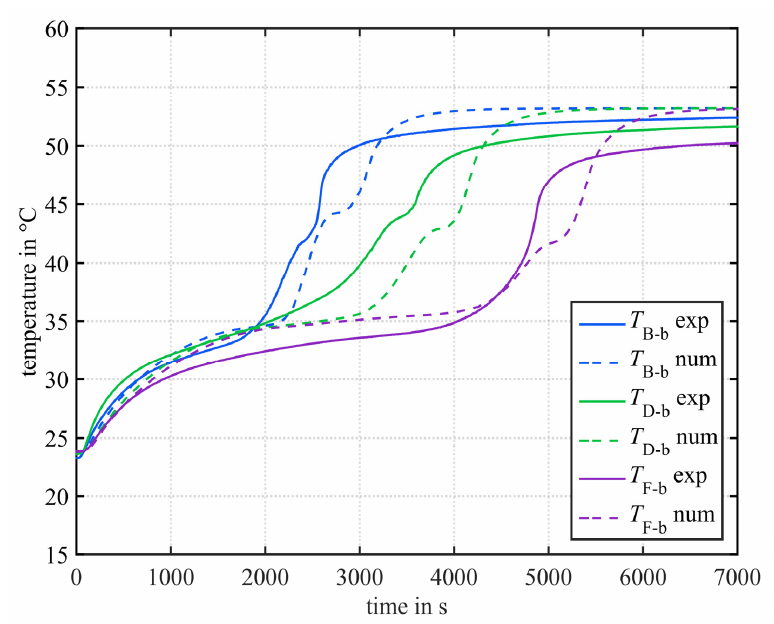
Figure 5. Comparison between experiment and standard simulation for temperature curves during charging of measurement points with an identical radius.